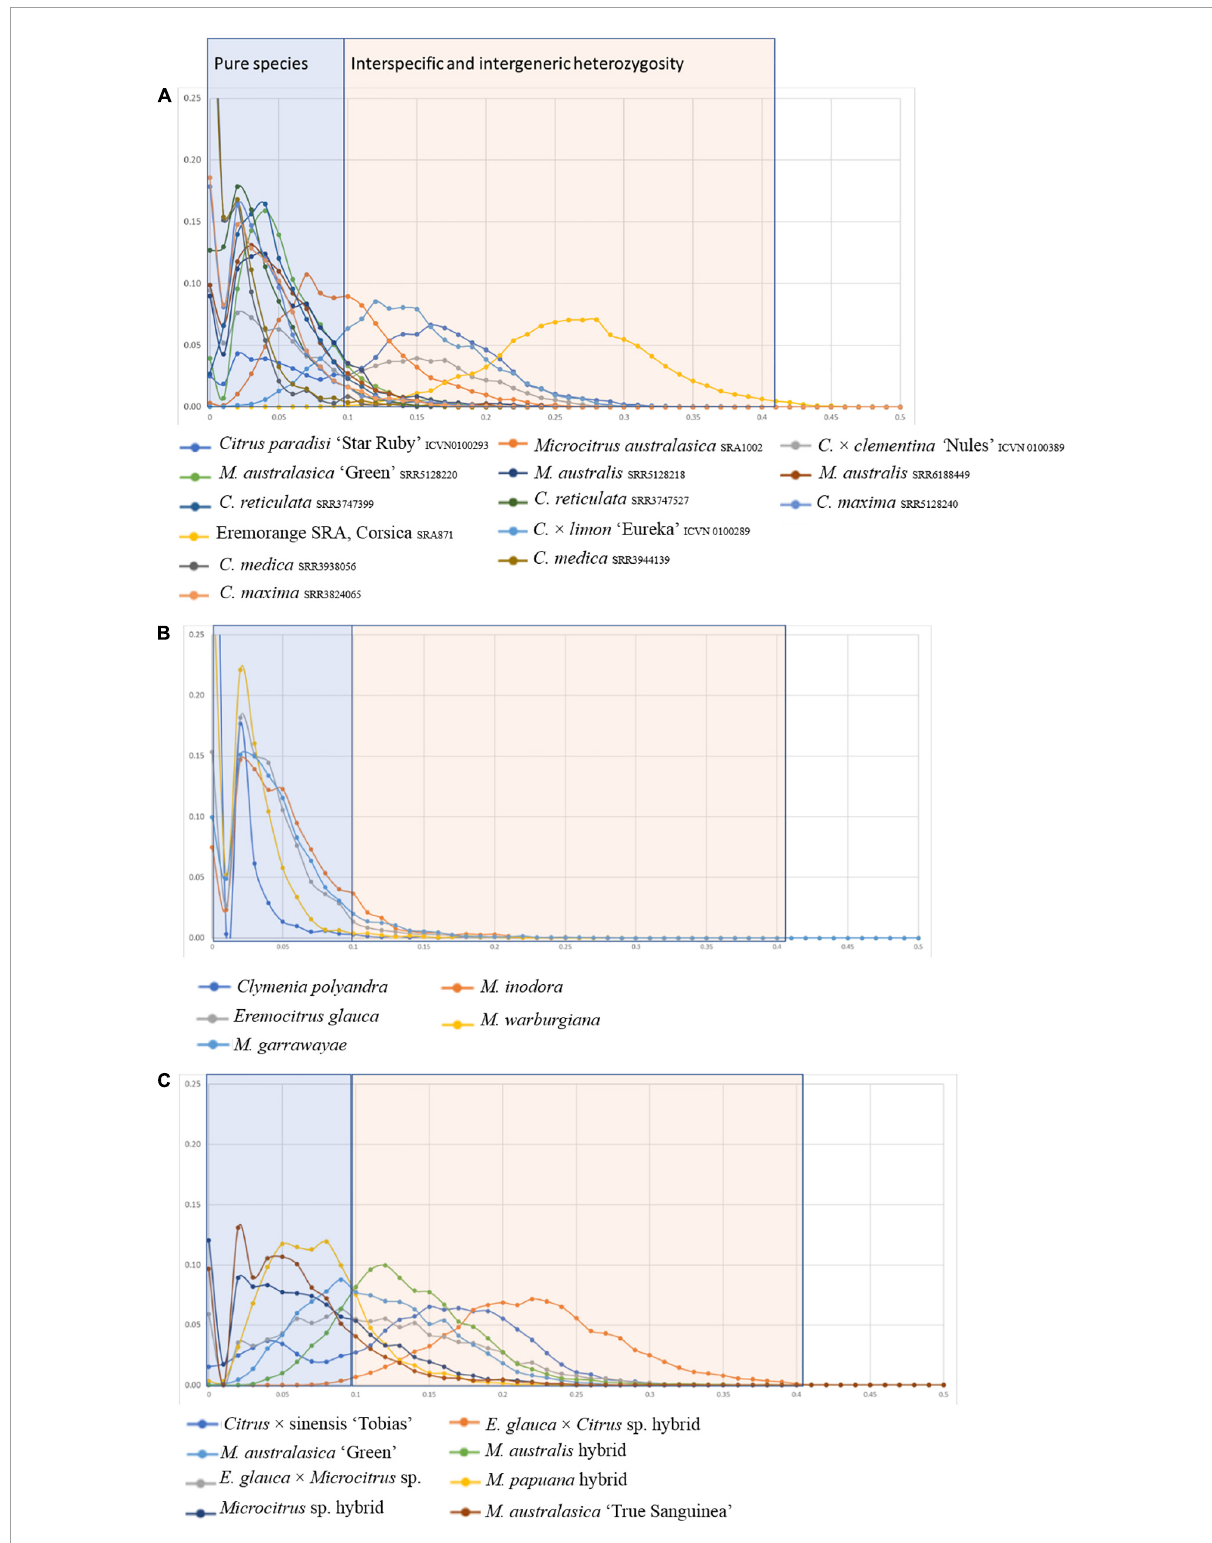
FIGURE4 Distribution of heterozygosity values for the 27 accessions, established from sliding windows of 100 successive SNPs. (A) Already published genome with known phylogenomic status; (B) pure specific accessions from Fundecitrus Oceanian germplasm; (C) interspecific and admixed accessions of Fundecitrus Oceanian